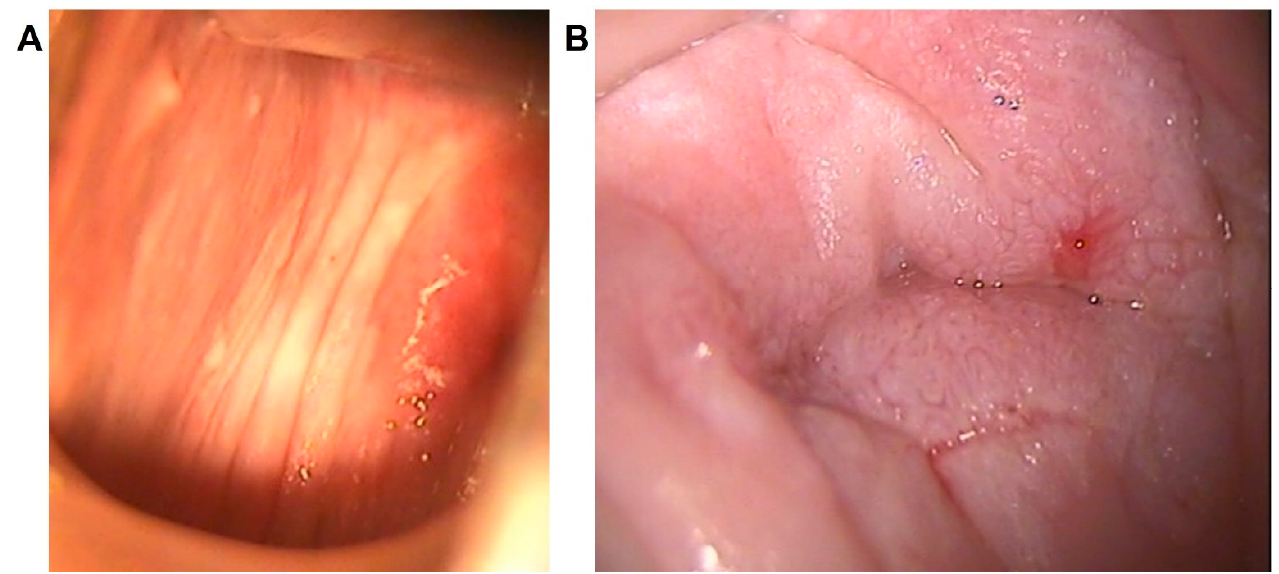
Figure 1. Colposcopic grade according to the 2011 IFCPC Colposcopic Terminology. ( A ): Grade 1 or minor, as shown by the colposcopic pattern (thin acetowhite epithelium) of a patient diagnosed with VAIN1, located at the upper third of the right vaginal wall. ( B ): Grade 2 or major, as shown by the colposcopic pattern (coarse mosaic) of a patient diagnosed with VAIN3, located at the vaginal vault, after previous hysterectomy for CIN3.